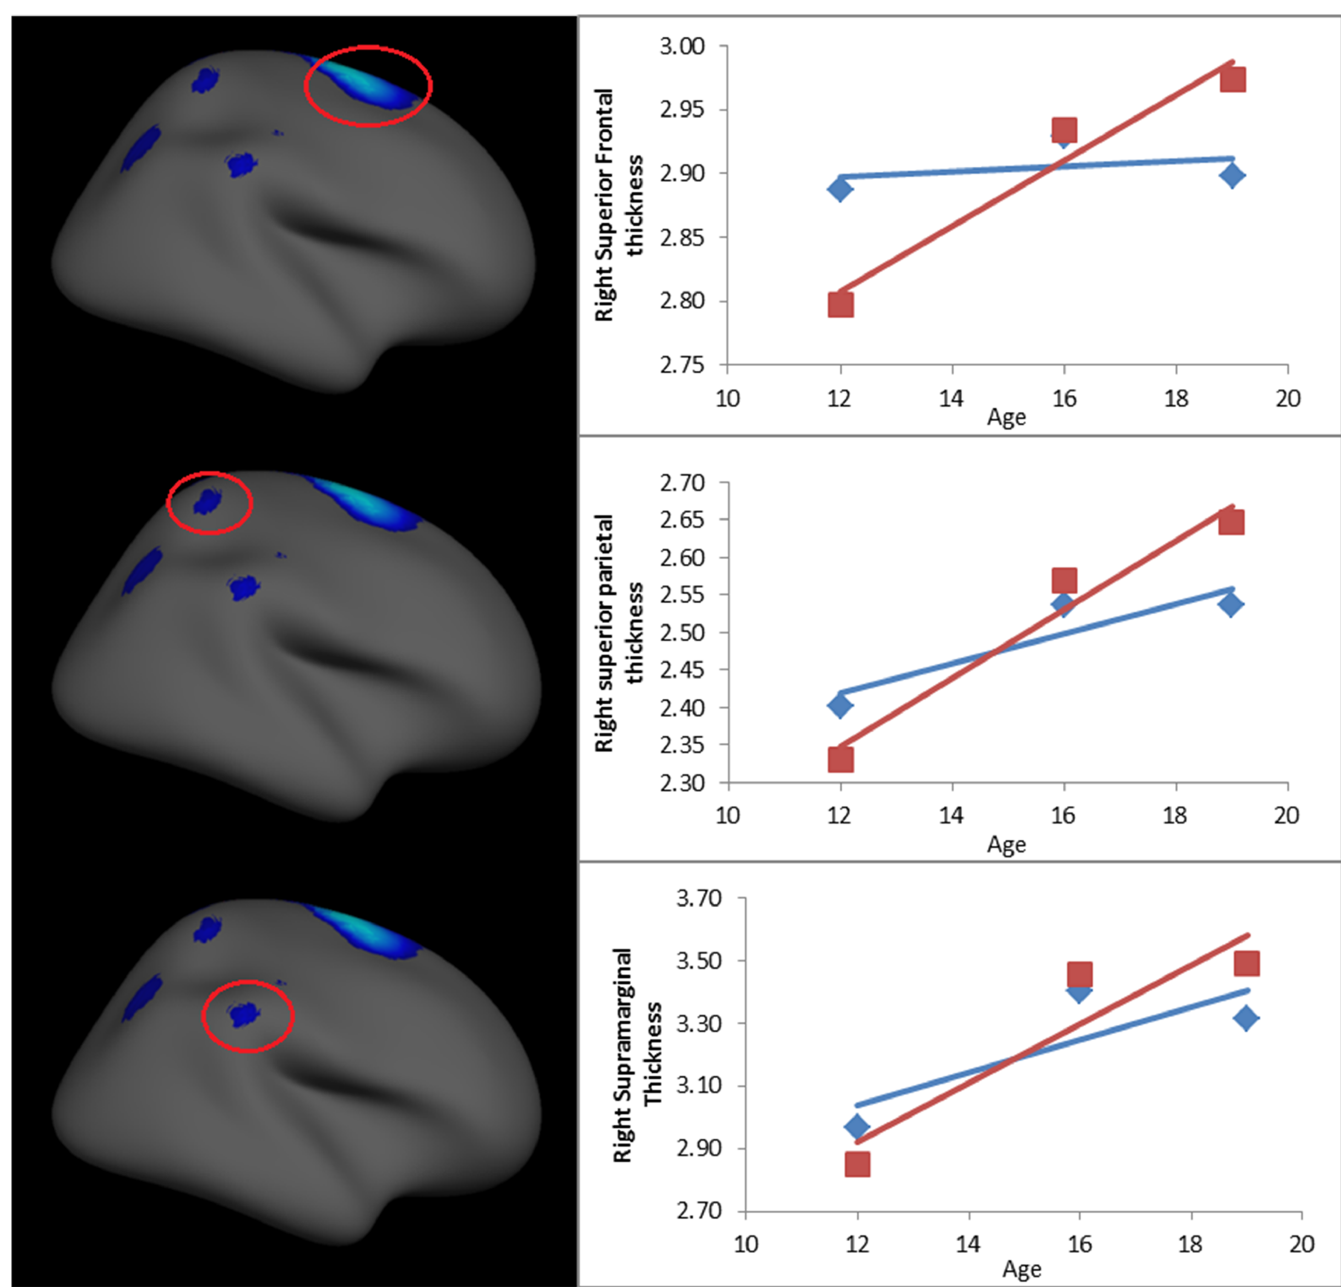
Fig 2. Mother aggressive behavior by age interaction for clusters that survived FDR (p < 0.05) correction for males. Data points represent predicted volume at each time point, and red and blue lines represent fitted age curves, for adolescents with high and low aggressive mothers,